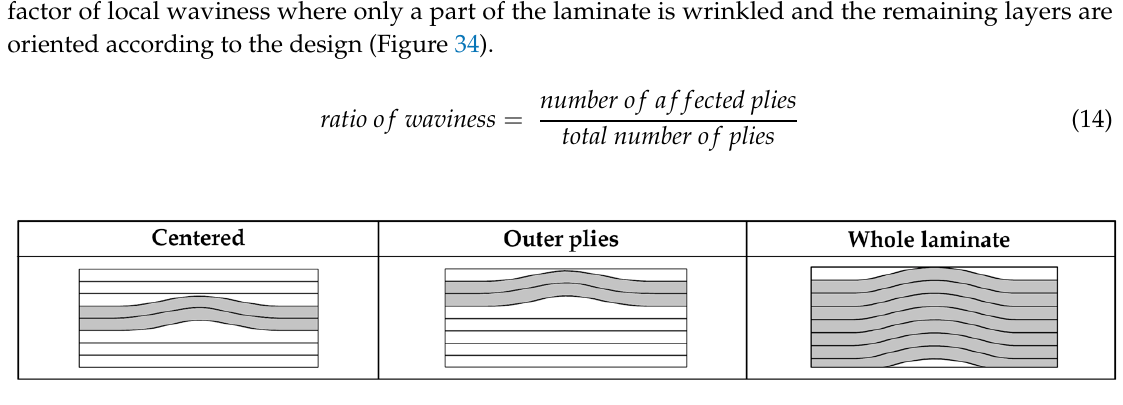
Figure 33. Waves at continuous vs. non-continuous plies.